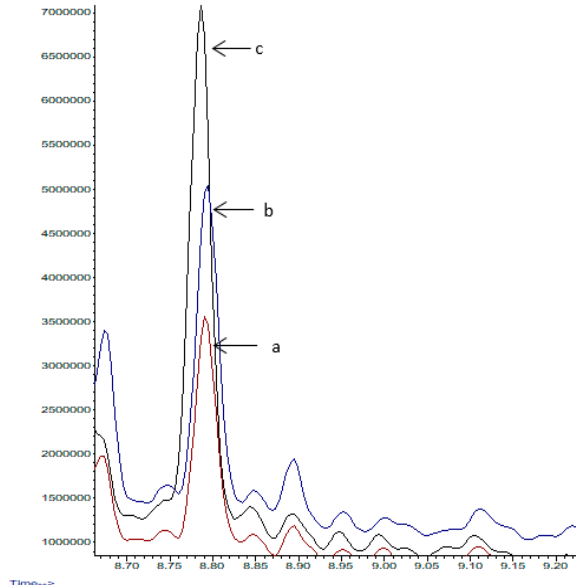
Figure 5. Chromatogram of s-metolachlor in soybean straw samples ( a ) and spiked soybean straw samples at 0.05 ( b ) and 0.1 mg kg − 1 ( c ).